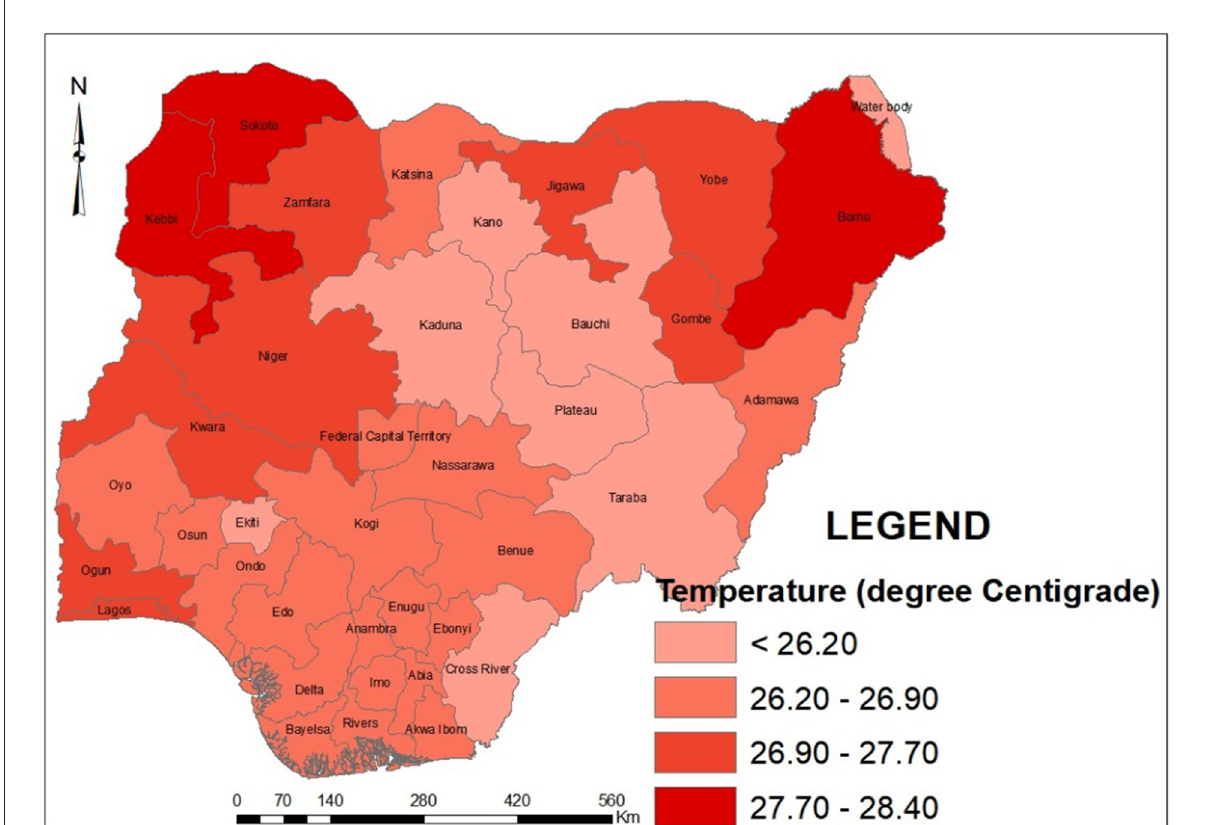
FIGURE3 Mean temperature over Nigeria. (1901–2020). Source: Derived from CRU dataset via Climate-change Knowledge Portal-World